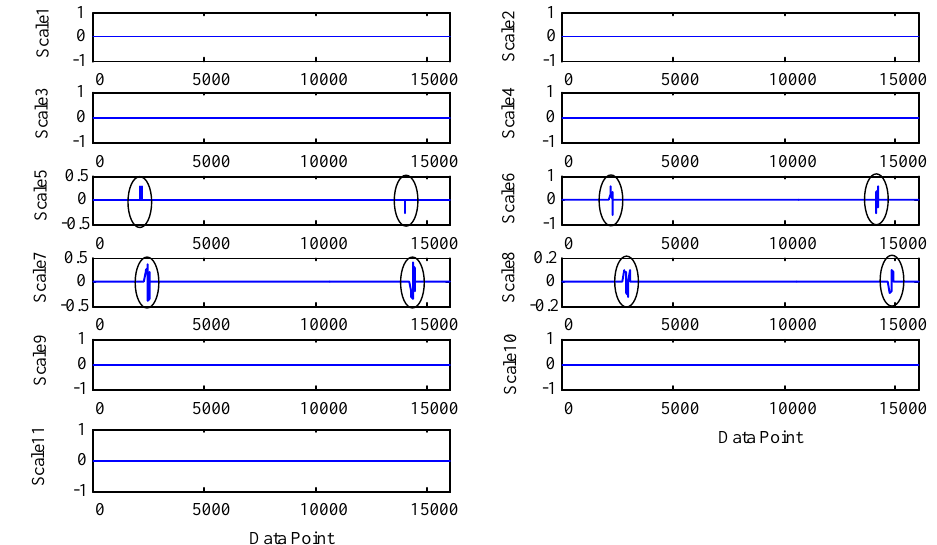
Figure 5. Wavelet coefficient shrinkages for all scales. For convenience, the profile coefficients of the scale 10 are marked as “scale 11”. At each scale, coefficients related to particle signatures are highlighted using